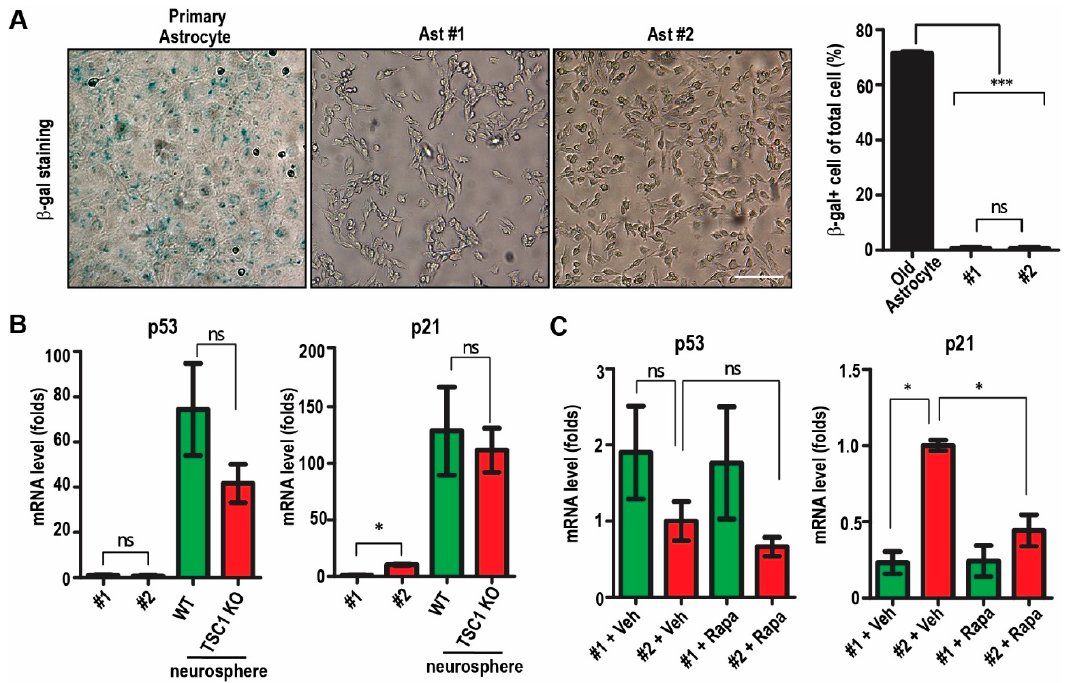
Figure 3. Immortalized cell lines of Ast #1 and Ast #2 passed senescence at early stage in vitro. ( A ) Representative images of β -gal staining for senescence from aged primary astrocyte (>1 year) and from immortalized Ast #1 and Ast #2 at passages of 35. Mean ± S.E. of the percentage of β -gal positive cells in aged astrocyte, Ast #1 and Ast #2 are shown on the right. Experiments were repeated 5 times for each type of cells. ( B ) Mean ± S.E. of the relative mRNA expression levels of p53 and p21 from Ast #1, Ast #2 and neurospheres from WT and Tsc1 cKO mice are shown. Four independent experiments were performed with similar results. ( C ) Mean ± S.E. of the relative mRNA expression levels of p53 and p21 from Ast #1, Ast #2 with or without Rapamycin treatment were shown. Four independent experiments were performed with similar results. Two-way ANOVA and Tukey post hoc tests were used for statistic tests. ns: no significance, * p < 0.05, ***: p < 0.001. Bar = 50 µm.